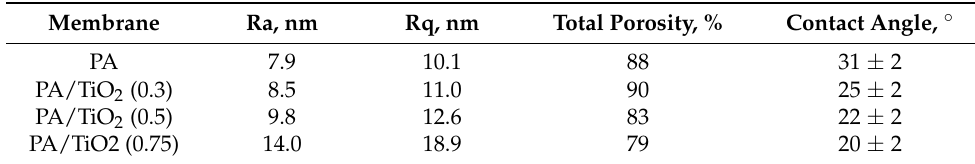
Table 1. Surface roughness parameters, total porosity, and water contact angle of PA and PA/TiO 2 membranes.